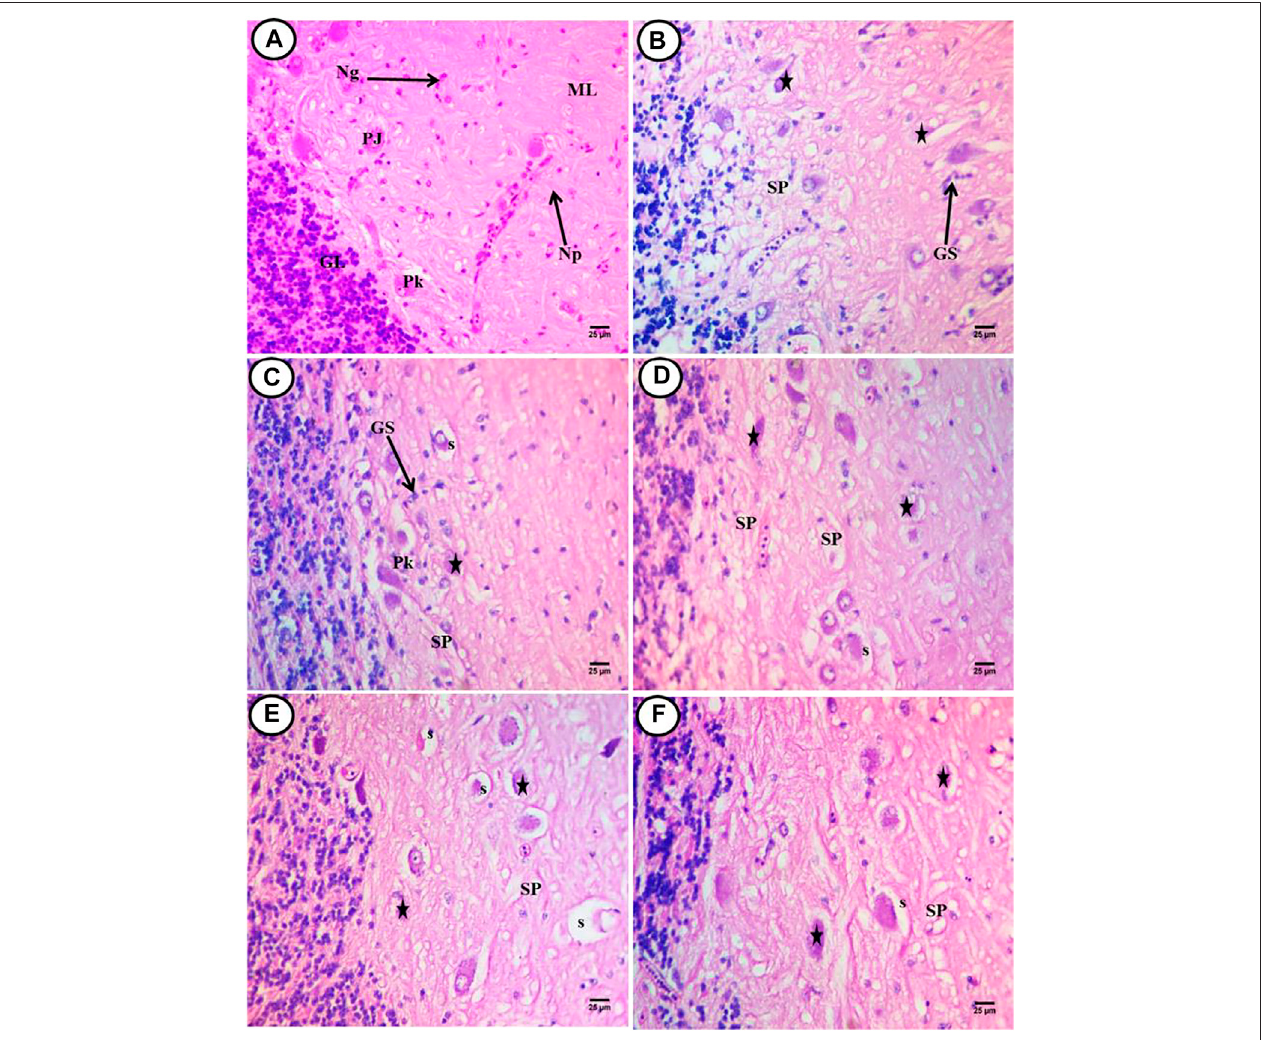
FIGURE 2 | Transverse sections of cerebellum of African cat fi sh ( C. gariepinus ) exposed to PE-MPs and PE-MPs with lycopene, citric acid and chlorella as antioxidantsfor15 days. (A) control fi shshowingnormalhistologyofbraintissue(cerebellum), PJ ;purkinjecells, Np; neuropil, Ng ;neuroglialcells, GL ;granularlayerand ML ;molecularlayer. (B,C) (PE-MPs500 mg/kgdiet)dose, (D) PE-MPs+lycopene(500 mg/kgdiet)dose, (E) PE-MPs+citricacid(30 g/kgdiet)doseand (F) PE-MPs+ chlorella (50 g/kg diet). (Star); deformed and necrotic neurons, SP; vacuolization of the neuropil (spongiosis), GS; aggregated neuroglial cells (gliosis), Pk; pyknotic neurons and s; shrunken purkinje cells. H&E. Scale bar 25